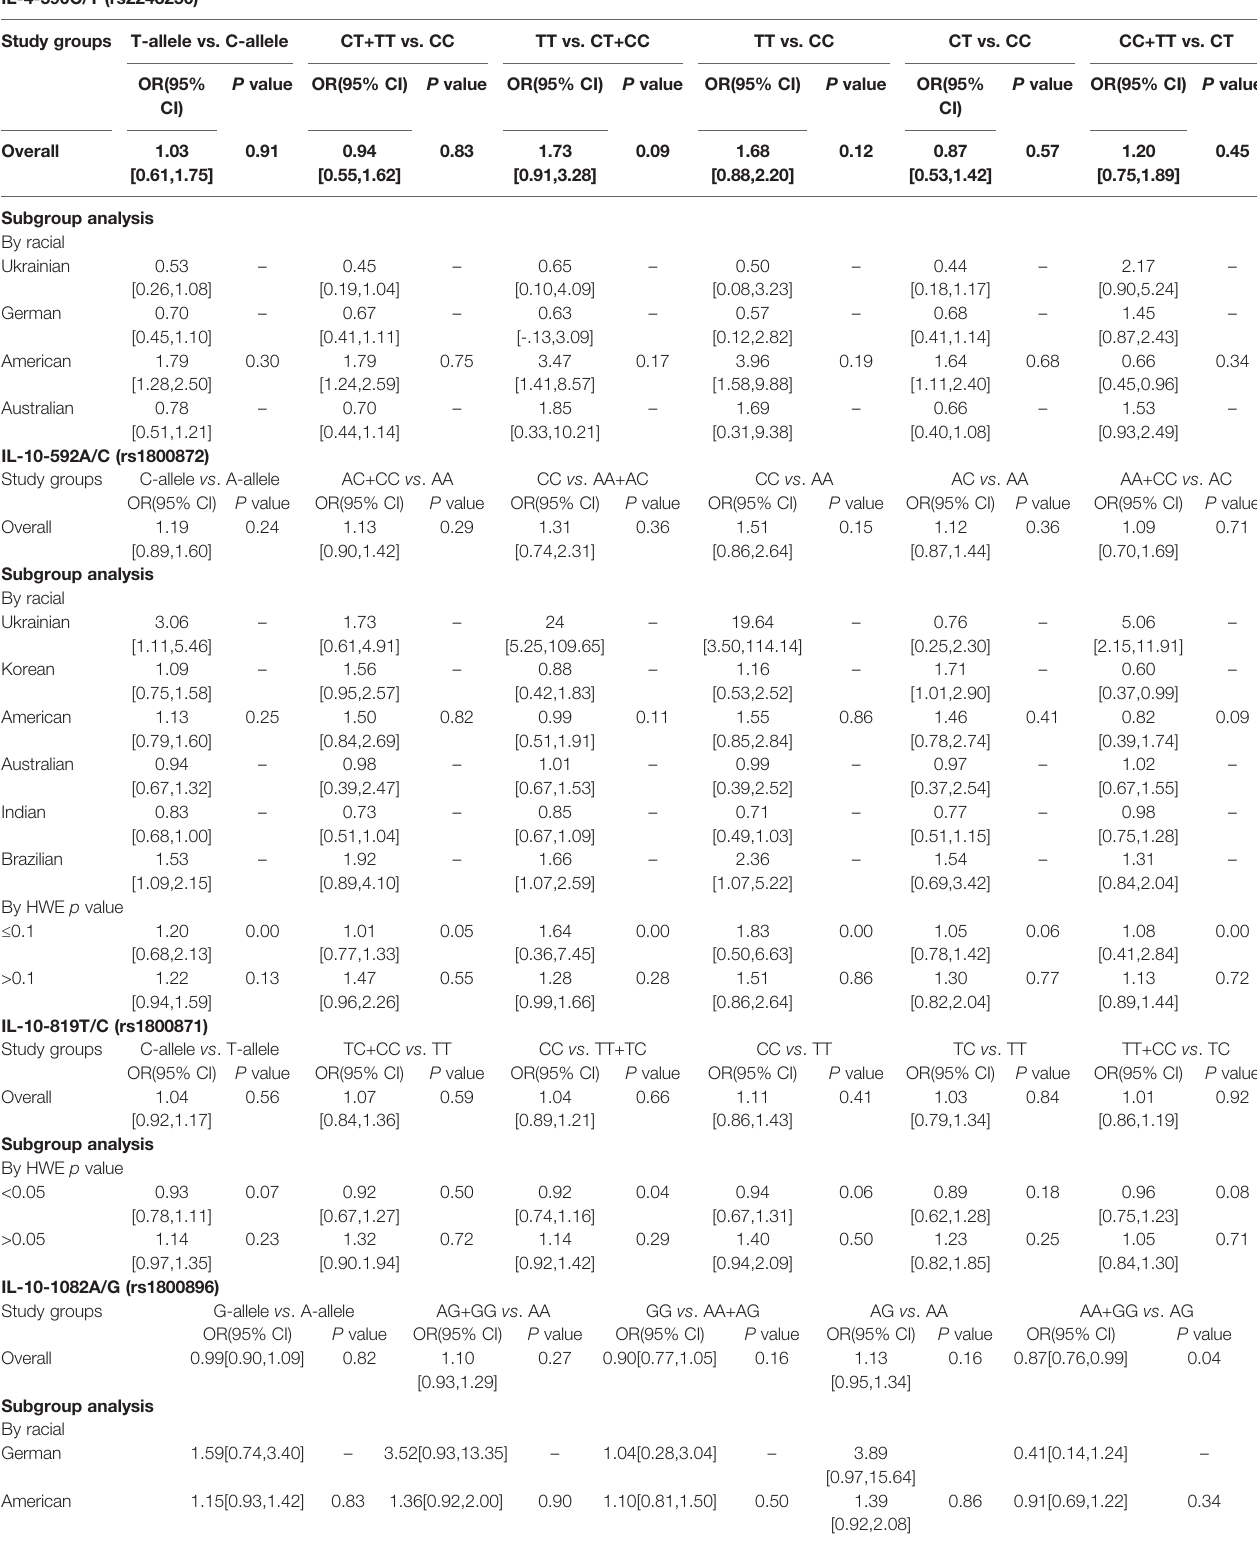
TABLE 2 | Main results of the total and subgroup analysis. IL-4-590C/T